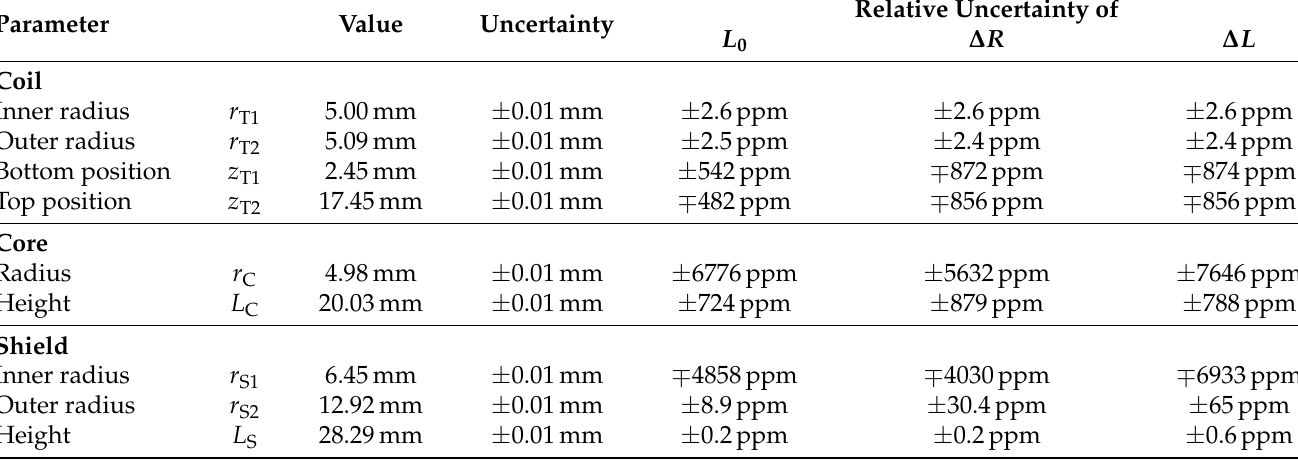
Table 3. Relative uncertainty of sensor impedance in the case of ± 0.01mm uncertainty in sensor dimensions. The plate has σ = 5MS/m and µ r = 50, lift-off is 0µm and the frequency is